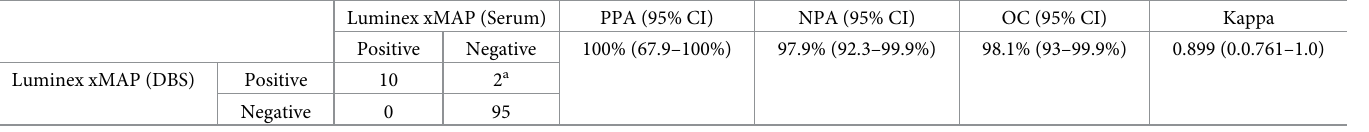
Table 2. Anti-SARS-CoV-2 antibody result comparison between 107 paired DBS and serum samples tested by the Luminex xMAP assay and interpreted based on manufacturer recommended MFI threshold